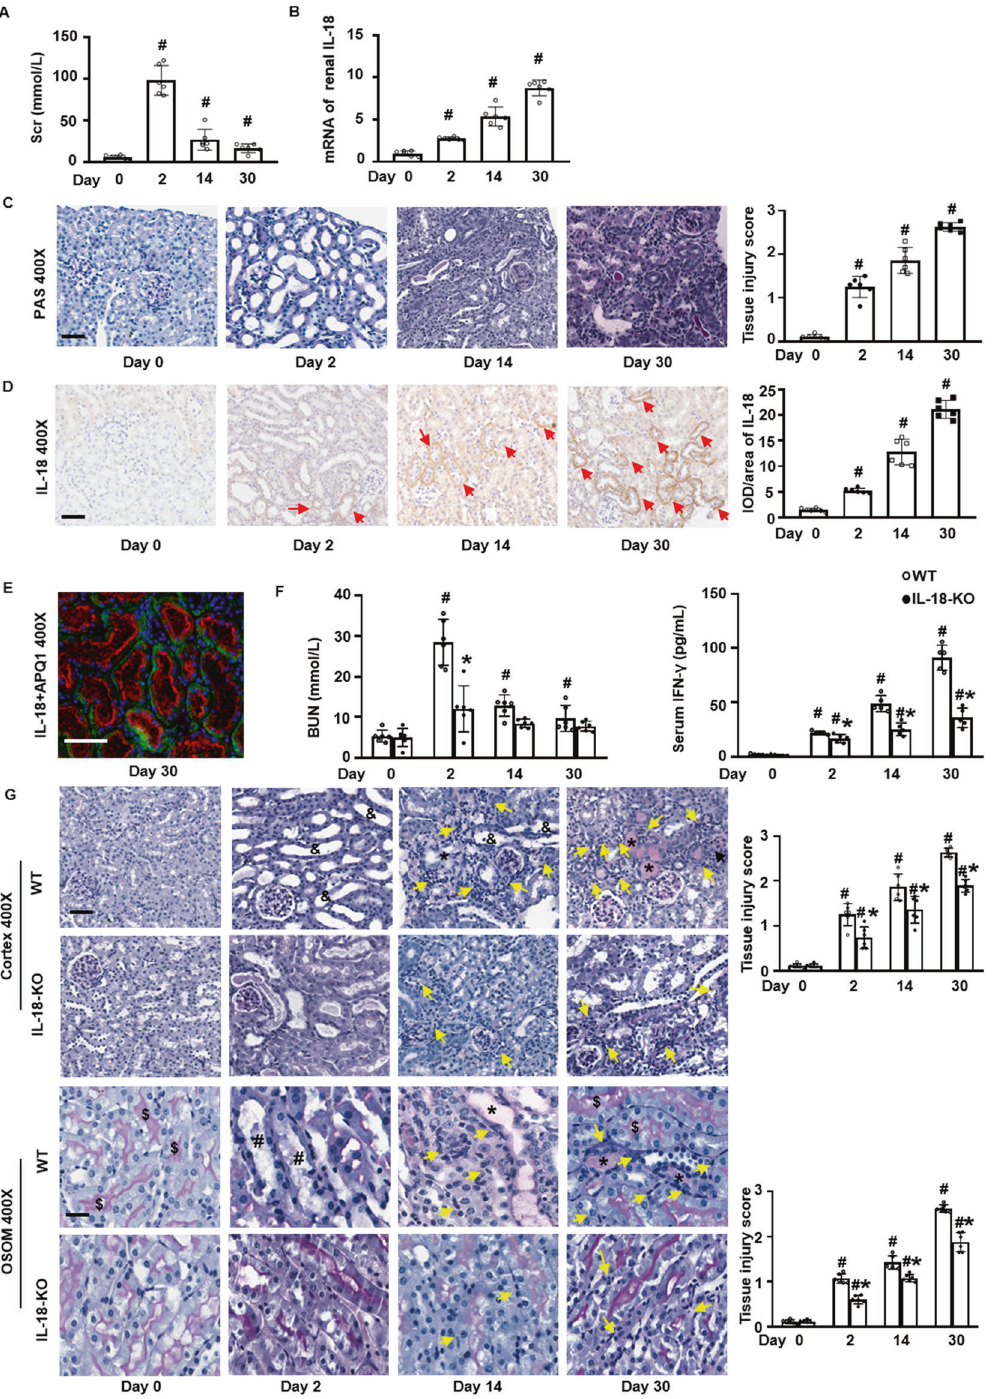
Fig. 1 IL-18 deletion attenuates acute and chronic kidney injury in folic acid-induced mice. A The temporal changes of serum creatinine (Scr) and B renal mRNA of IL-18 expression following folic acid (FA) injection to wild type mice (WT). C , D kidney injuries on PAS staining and the semi-quanti fi cation of the injuries ( C ) and immunohistochemistry staining of IL-18 and its semi-quanti fi cation ( D ). E Double immuno fl uorescence staining of IL-18 (green) and AQP-1 (red) in the relative normal renal cortex tubular cells in WT mice at day 30 after FA injection. F Blood urea nitrogen (BUN) and Serum interferon- γ (IFN- γ ) in IL-18 knockout mice (IL-18 KO) compared to WT mice. G PAS staining and its semi-quanti fi cation in renal cortex and outer medulla (OSOM). Red arrow indicates IL-18 positive staining. $ Normal brush border, & loss of brush border and dilation of tubular lumen, *Protein cast, # Detachment of tubular epithelial cells from tubular basement membrane and debris in tubular lumen. Yellow arrows indicate the in fi ltration of in fl ammatory cells. Magni fi cation, 400 × bar = 50 um. Data represents Mean ± SD. ( n = 6, # p < 0.05, other groups vs. day 0; * p < 0.05, KO vs. WT).